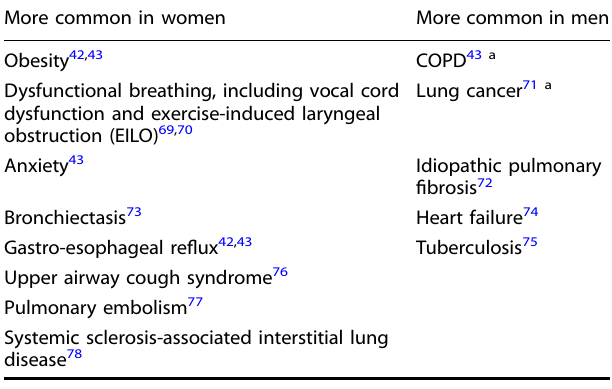
Table 1. Differential diagnoses of asthma in men and women.